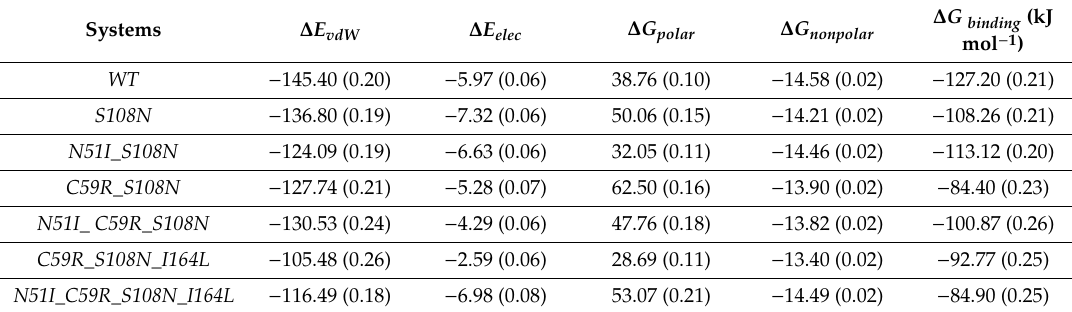
Table 1. Thermodynamic analysis: Comparisons of binding energy between wild type and mutated Key: van der Waals: ∆ E vdW , Electrostatic: ∆ E elec, polar solvation: ∆ G polar , nonpolar: ∆ G nonpolar